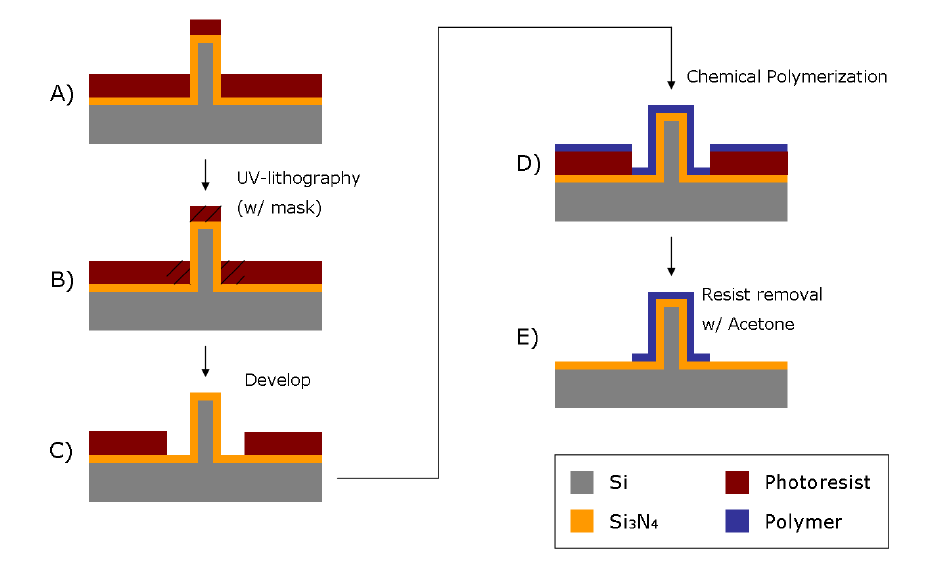
Figure 2. Schematic illustration of polymer film patterning. ( A ) Spin-coating of photoresist onto a silicon nitride surface previously deposited on a silicon wafer (containing the pillar structures); ( B ) Mask assisted UV-lithography; ( C ) Photoresist development; ( D ) Chemical synthesis of polymer film on the surface; ( E ) Sacrificial resist removal with acetone.